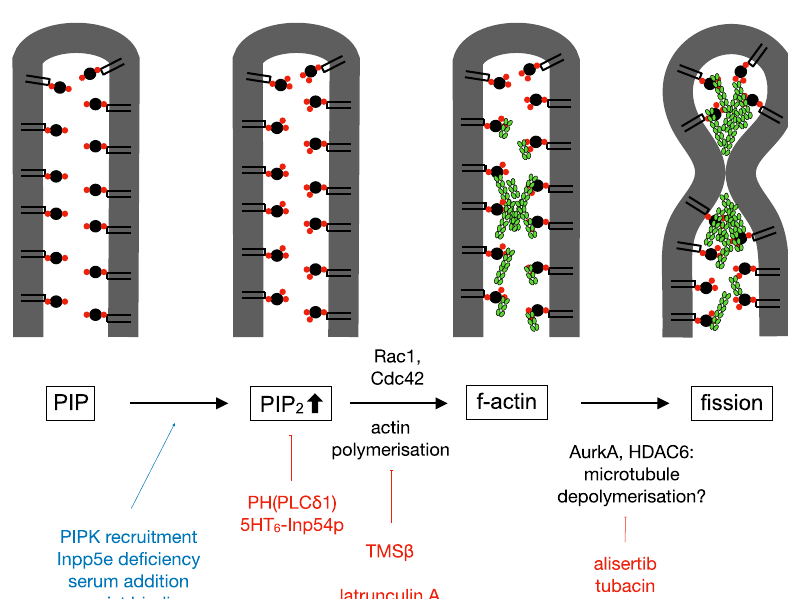
Fig. 7 Illustration of proposed mechanism. a Summary of membrane turnover and regulation of ciliary length. Ciliary length remains stable because membrane insertion and membrane removal are balanced. Top: Cilia grow by fusion of Golgi-derived vesicles with the periciliary membrane. Blocking vesicle fusion by DN Rab8 or brefeldin A blocks growth and reduces ciliary length if membrane removal continues. Elongation of the ciliary membrane is accompanied by elongation of ciliary microtubules (green). Bottom: Endocytosis and ciliary fi ssion reduce ciliary length. Fission can be induced by PIP 2 increase (synthesis or impaired Inpp5e), activation of G-protein coupled receptors (GPCR) or serum exposure. Blocking these processes by PIP 2 depletion, TMSß, DN Rac1, alisertib or tubacin increases ciliary length if vesicle fusion continues. Ciliary microtubules need to be severed for ciliary shortening. b Proposed molecular pathway of ciliary fi ssion. Recruitment of PIPK and de fi ciency of the 5-phosphatase Inpp5e lead to an increase in ciliary PIP 2 . Serum addition and agonist binding (in the presence of DN dynamin) have the same effect. The PIP 2 increase can be prevented by sequestering PIP 2 using PH(PLC δ 1) or by constitutive expression of the 5-phosphatase Inp54p. The PIP 2 increase leads to polymerisation of g-actin to f-actin, presumably ampli fi ed by help of the Rho kinases Rac1 and Cdc42. Actin polymerisation can be prevented by TMSß and latruculin A. AurkA and HDAC6 likely act downstream of actin polymerisation and could work by microtubule depolymerisation, which is also required for ciliary fi ssion. AurkA and HDAC are inhibited by alisertib, respectively,